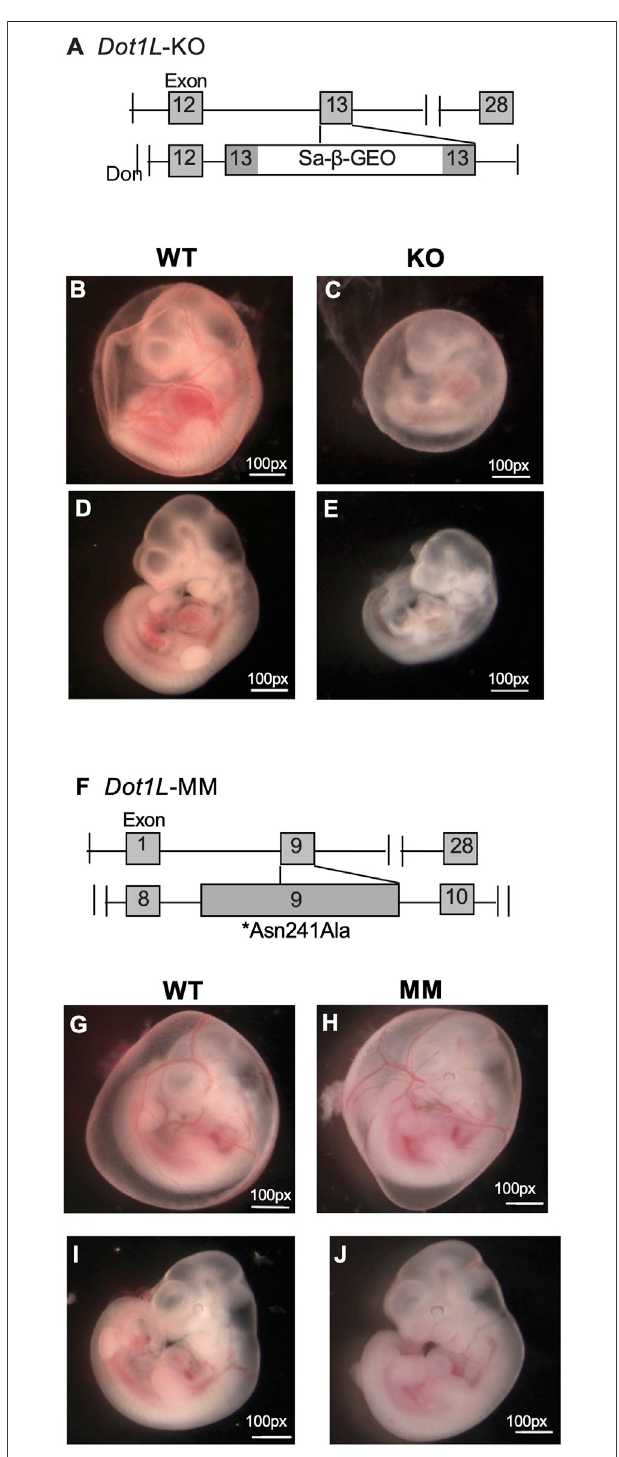
FIGURE 1 | Differential phenotypes of Dot1L -KO and Dot1L -MM embryos. Schematic representation of the gene trap construct used to generate the mutant Dot1L -KO alleles (A) . Representative images of E10.5 wildtype (WT) (B,D) , Dot1L -KO (C,E) , show that growth of Dot1L -KO embryos is slower than that of WT (B – E) . In addition, at E10.5, the KO